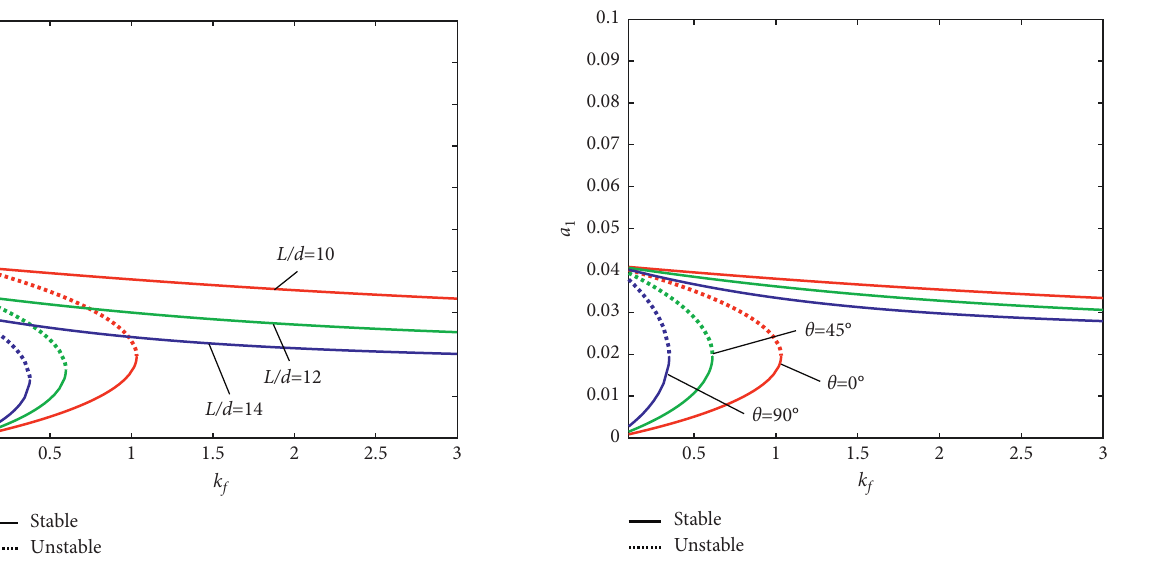
Figure 20: Amplitude versus cutting force coefficient with different ratios of length to diameter ( θ � 0 ° , c � 0.01, σ � 2, case I).